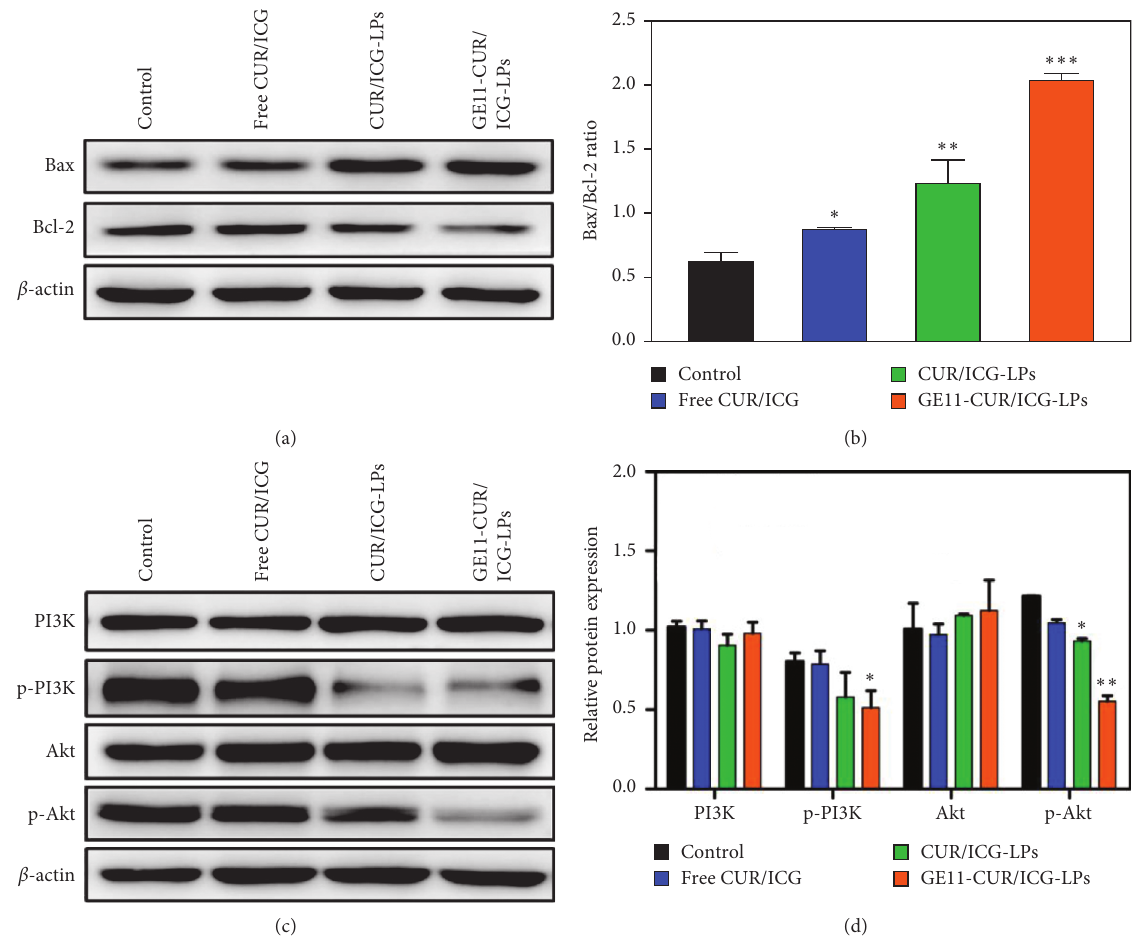
Figure 7: (a) Representative western blot and (b) quantification of Bcl-2 and Bax expression in A549 cells following treatment with PBS, free CUR/ICG, CUR/ICG-LPs, and GE11-CUR/ICG-LPs under 808nm laser irradiation for 5 min. Data are expressed as mean ± SD ( n � 3). ∗ P < 0 . 05 and ∗∗ P < 0 . 01. (c) Representative western blot and (d) quantification of PI3K, p-PI3K, Akt, and p-Akt expression in A549cells following different treatments with laser irradiation. Data are expressed as mean ± SD ( n � 3). ∗ P < 0 . 05, ∗∗ P < 0 . 01 and ∗∗∗ P < 0 .